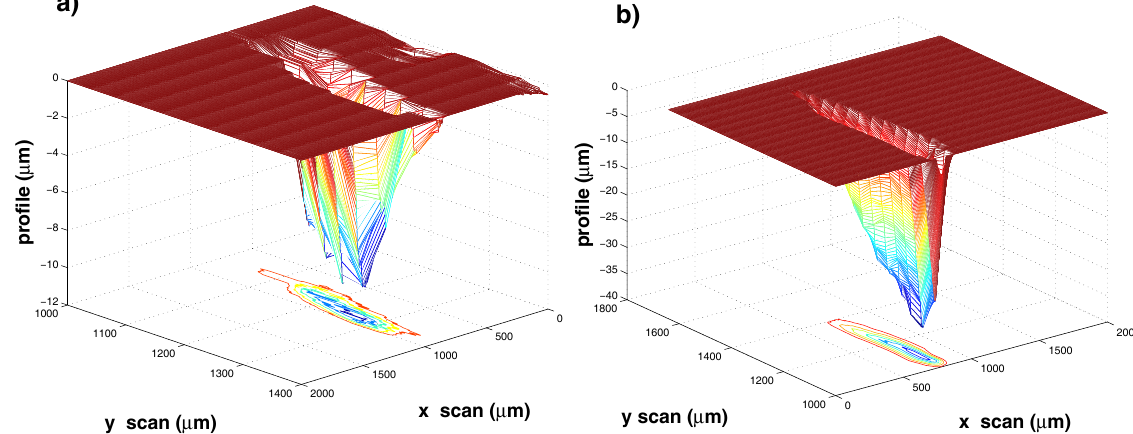
Figure 1. 3D representation of the craters produced on the surface of a silver target at 2.0 J · cm − 2 by ( a ) 50 and ( b ) 200 laser pulses. At the bottom are the corresponding contour